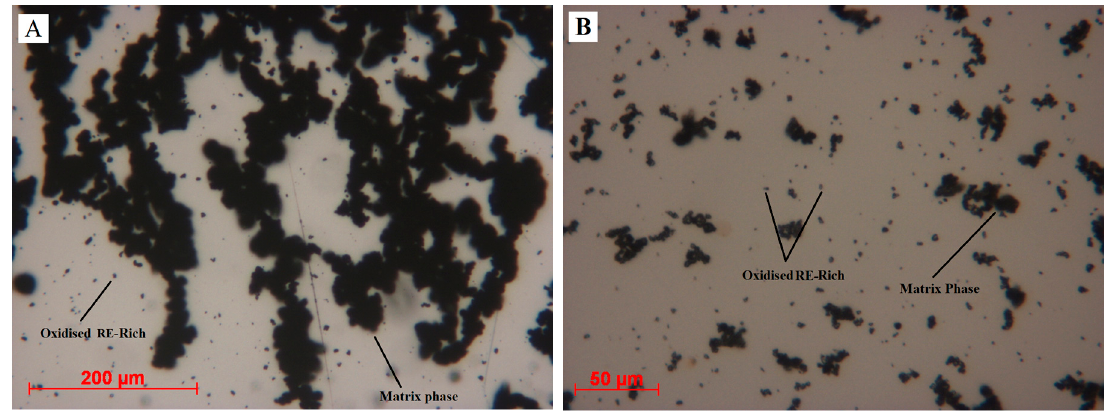
Figure 7. Underflow ( A ) and overflow ( B ) mixed with water and images taken by optical microscope.